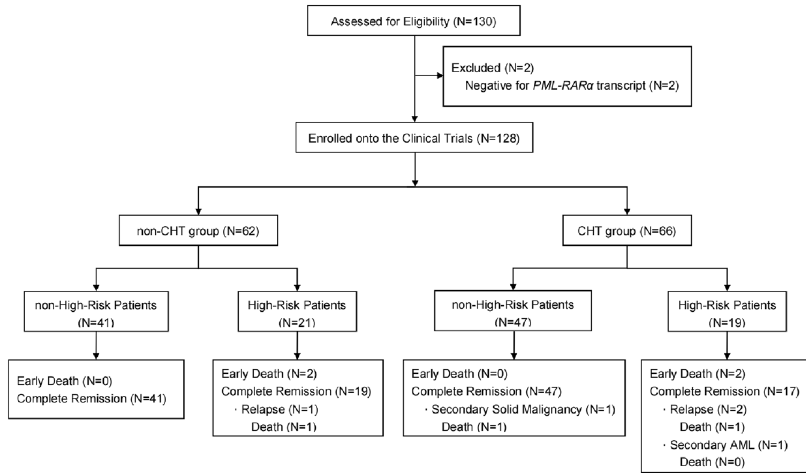
Fig. 2 Trial pro fi le. CHT